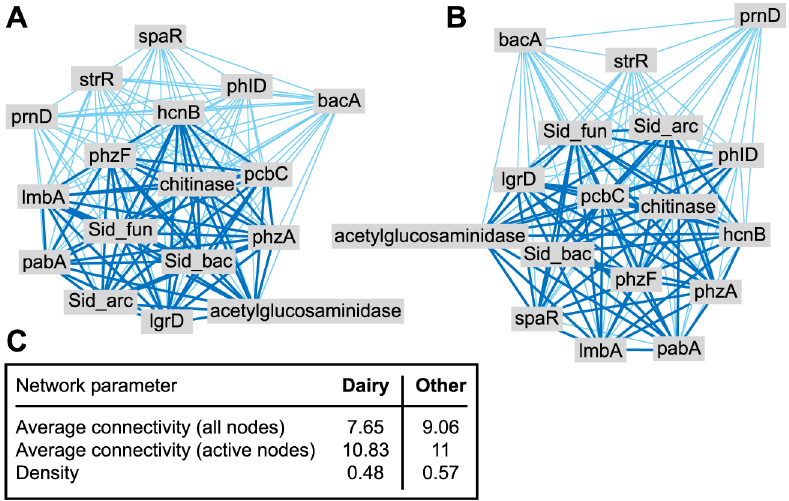
Fig 3. Network plots of disease suppressive functional gene abundance in (A) dairy (high intensity) and (B) other (low intensity) pasture soil. Nodes represent each individual gene, rather than gene categories, with a putative role in disease suppression. Edges (blue lines) correspond to associations between genes; bold lines reflect Pearson correlations (cid:21) 0.9, and fine lines correlations between 0.8 and 0.9. Sid_fun, Sid_arc and Sid_bac represent fungal, archaeal and bacterial siderophore production genes, respectively. (C) Measures of average connectivity and density were higher for other (low intensity) systems than for dairy (high intensity)